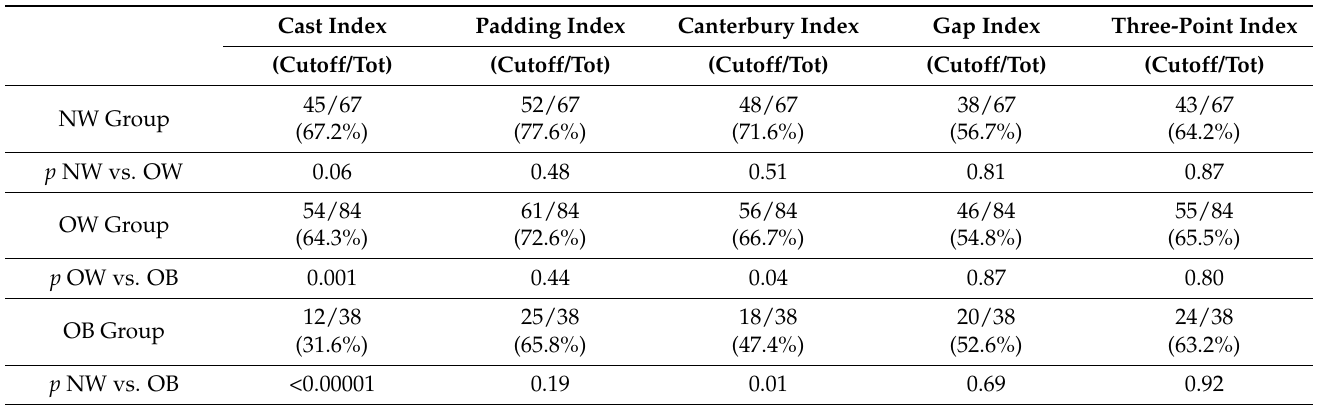
Table 3. Radiological indices for each